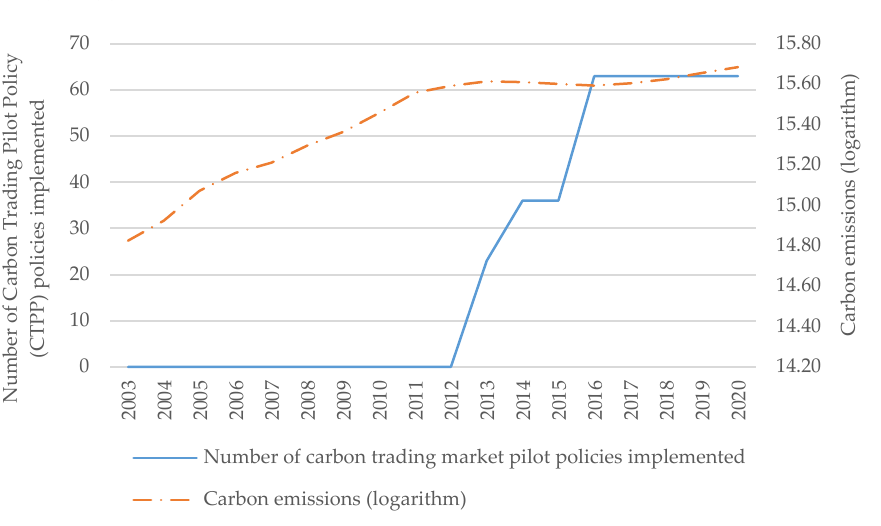
Figure 1. Number of cities in China implementing the Carbon Trading Pilot Policy (CTPP) and national carbon emissions (Source: Authors’ construct).